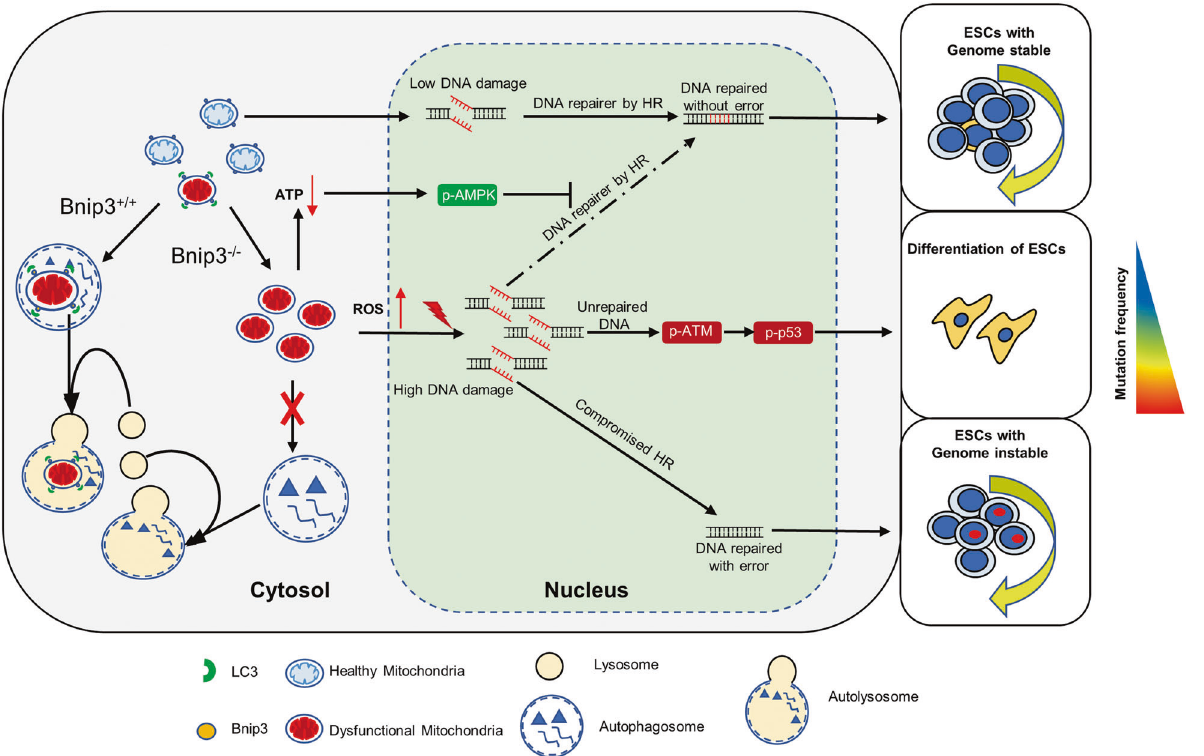
Fig. 5 BNIP3-dependent mitophagy safeguards ESC genomic integrity. Dysfunction of BNIP3-dependent mitophagy induces cellular ROS accumulation that leads to p53-mediated ESC differentiation, and decreased ATP generation that results in compromised AMPK-dependent homologous recombination. Reinforcement of BNIP3-dependent mitophagy during reprogramming improves iPSC genomic